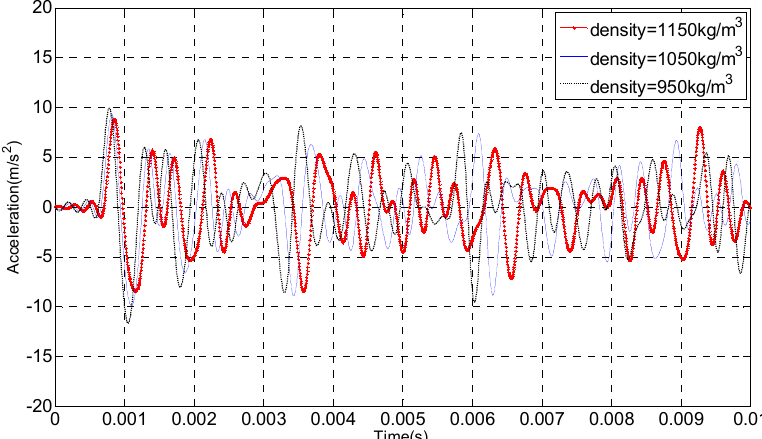
Figure 16. Wave propagation behaviours with different densities in isotropic material model.